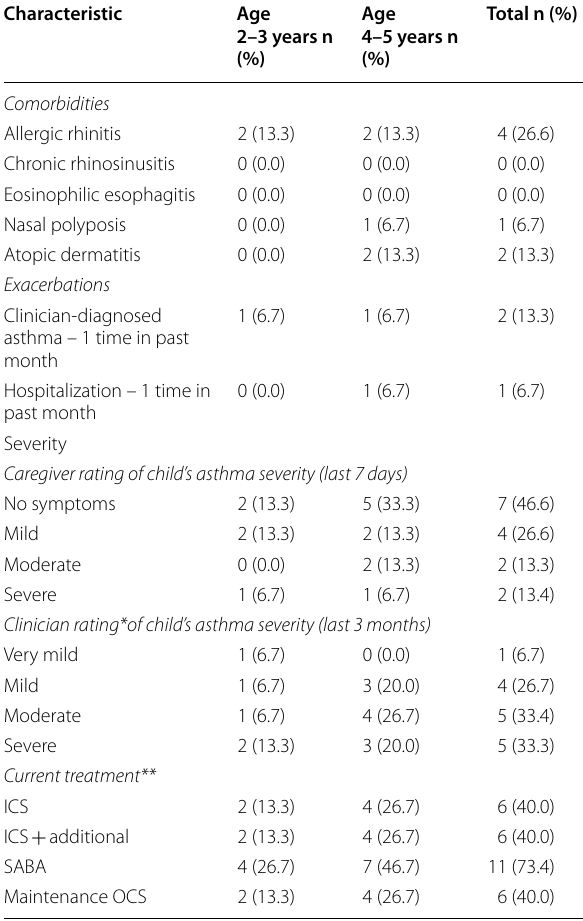
Table 2 Clinical characteristics of